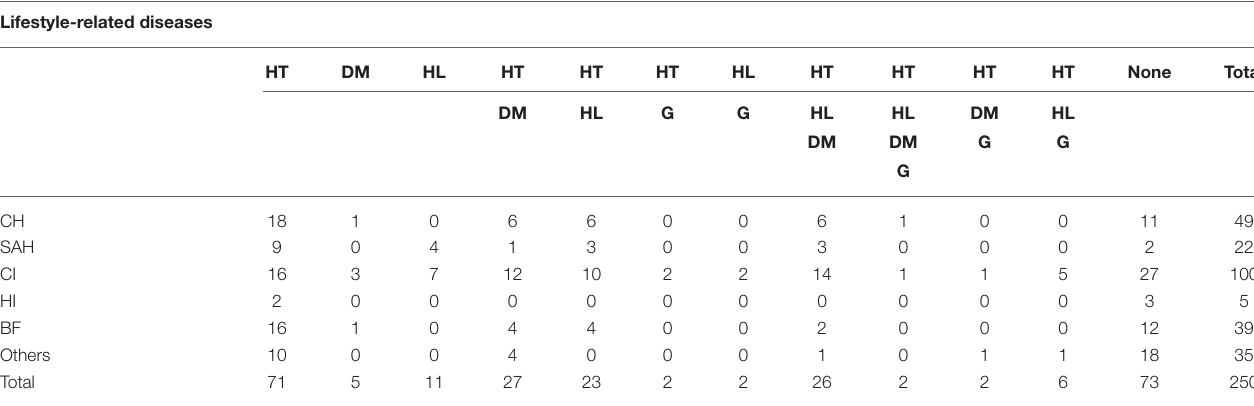
TABLE 3 | Clinical profiles of patients. Lifestyle-related